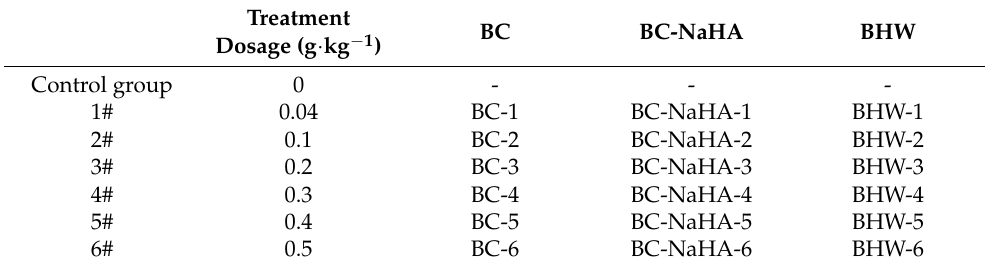
Table 1. The treatment groups include BC, BC-NaHA and